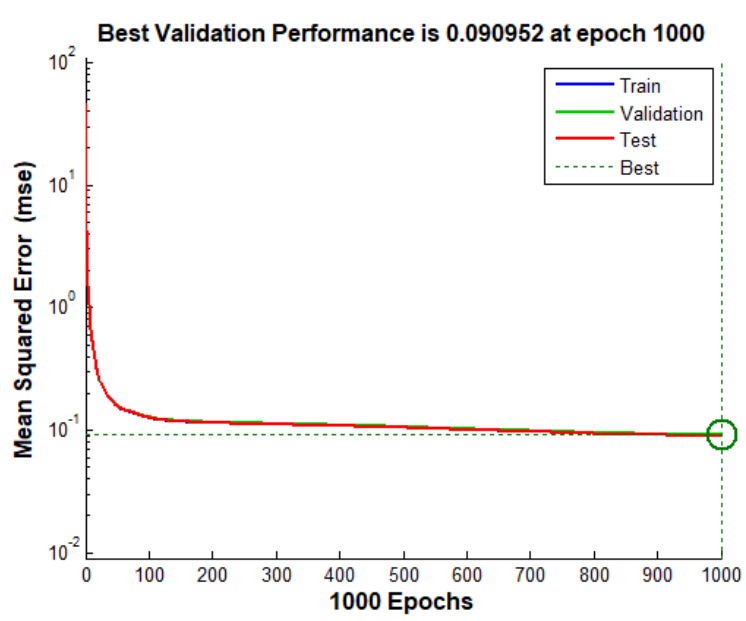
Fig. 2. Neural networks training iteration error graph based on GOCE training data sets